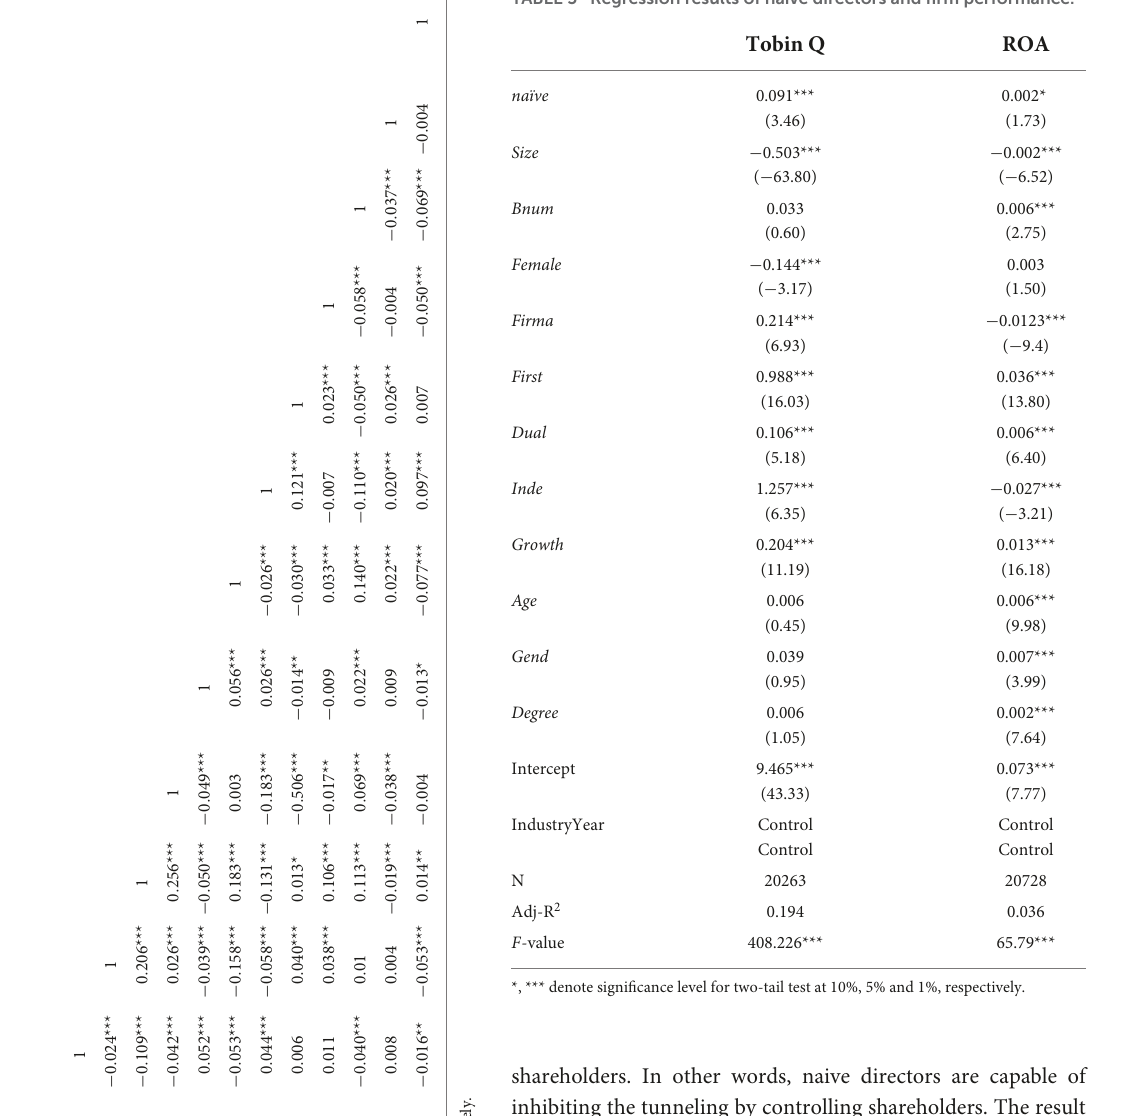
TABLE 5 Regression results of naive directors and firm